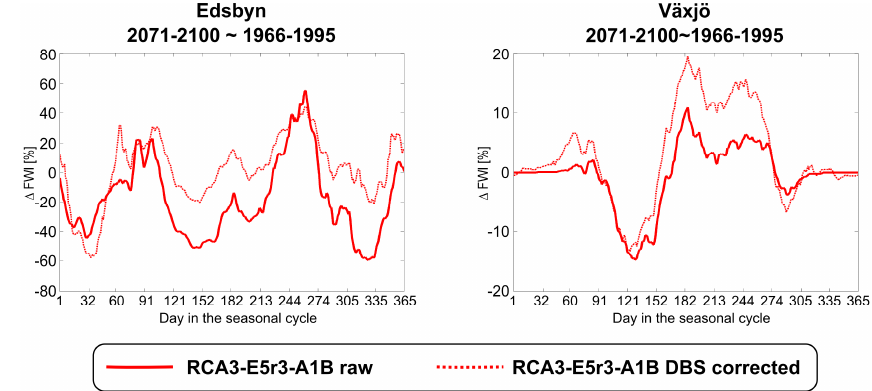
Figure 10. Climate change signals in the FWI reflected in RCA3-E5r3-A1B for the period of 2071–2100 with respect to the period 1966– 1995 at Edsbyn and Växjö station (see Fig. 1).